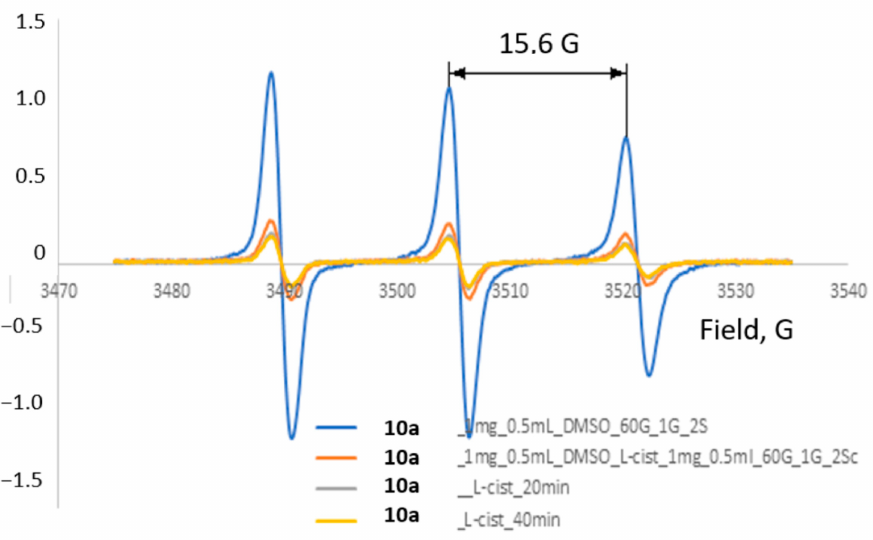
Figure 8. EPR spectra of 10a with the addition of a 5-fold excess of L-cysteine over time in THF at